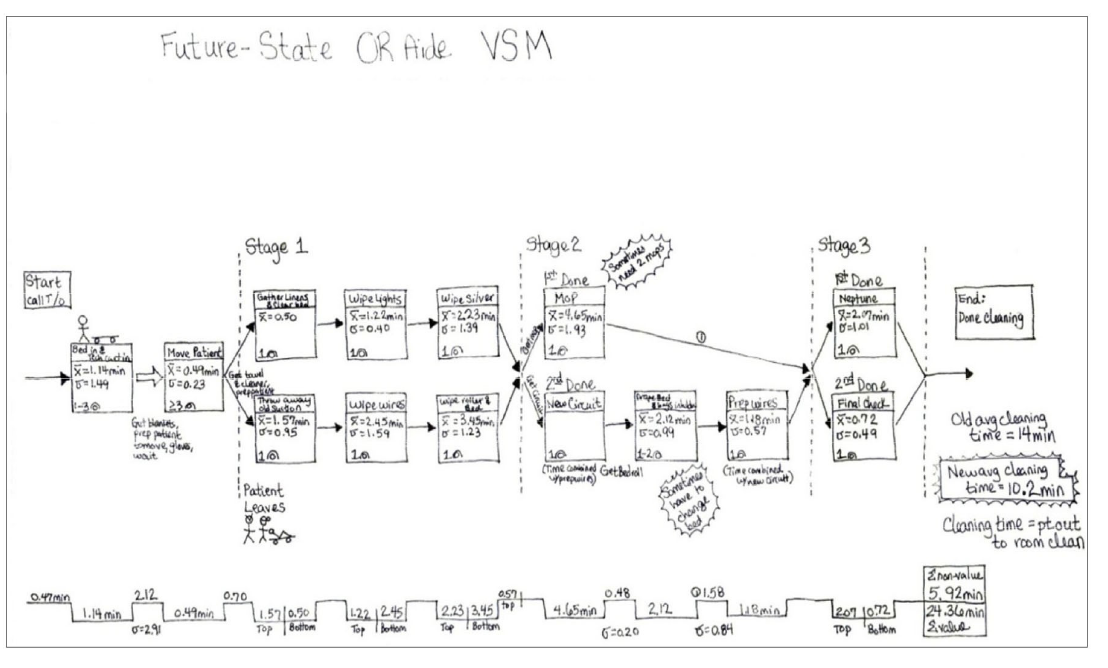
Figure 10. OR Aide Future (Implemented) State Value Stream